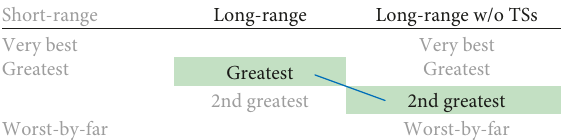
Table 16: Tabular representation of Rule 6b.